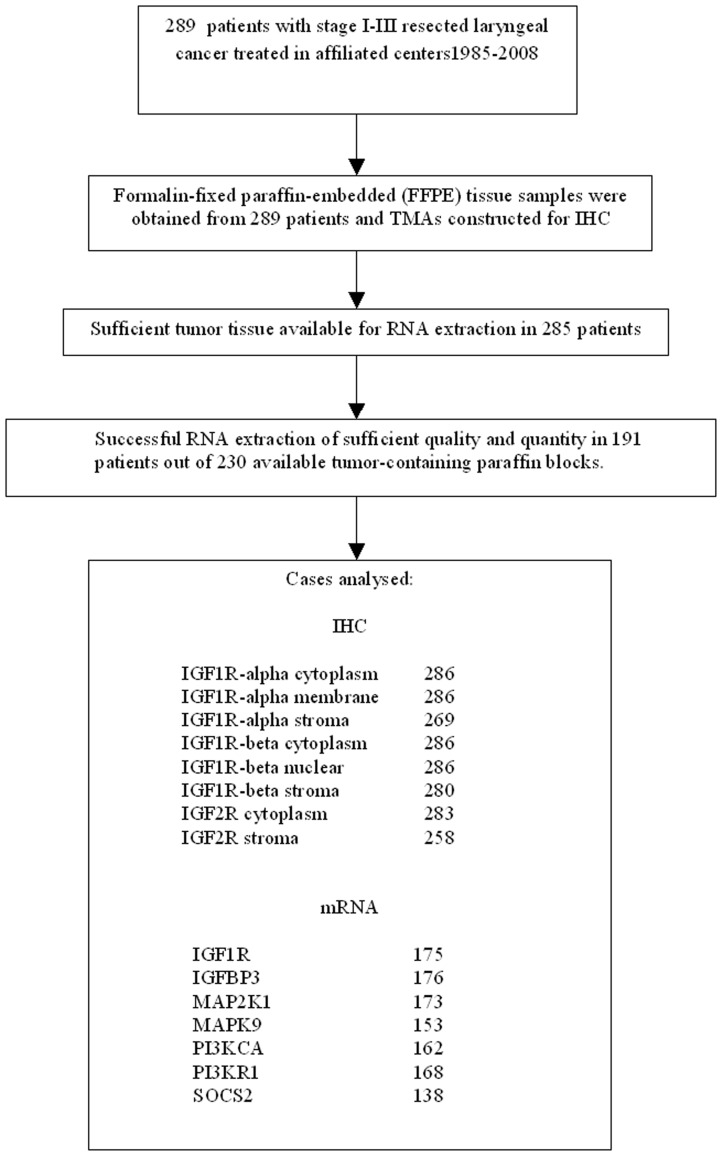
REMARK Flow Chart.